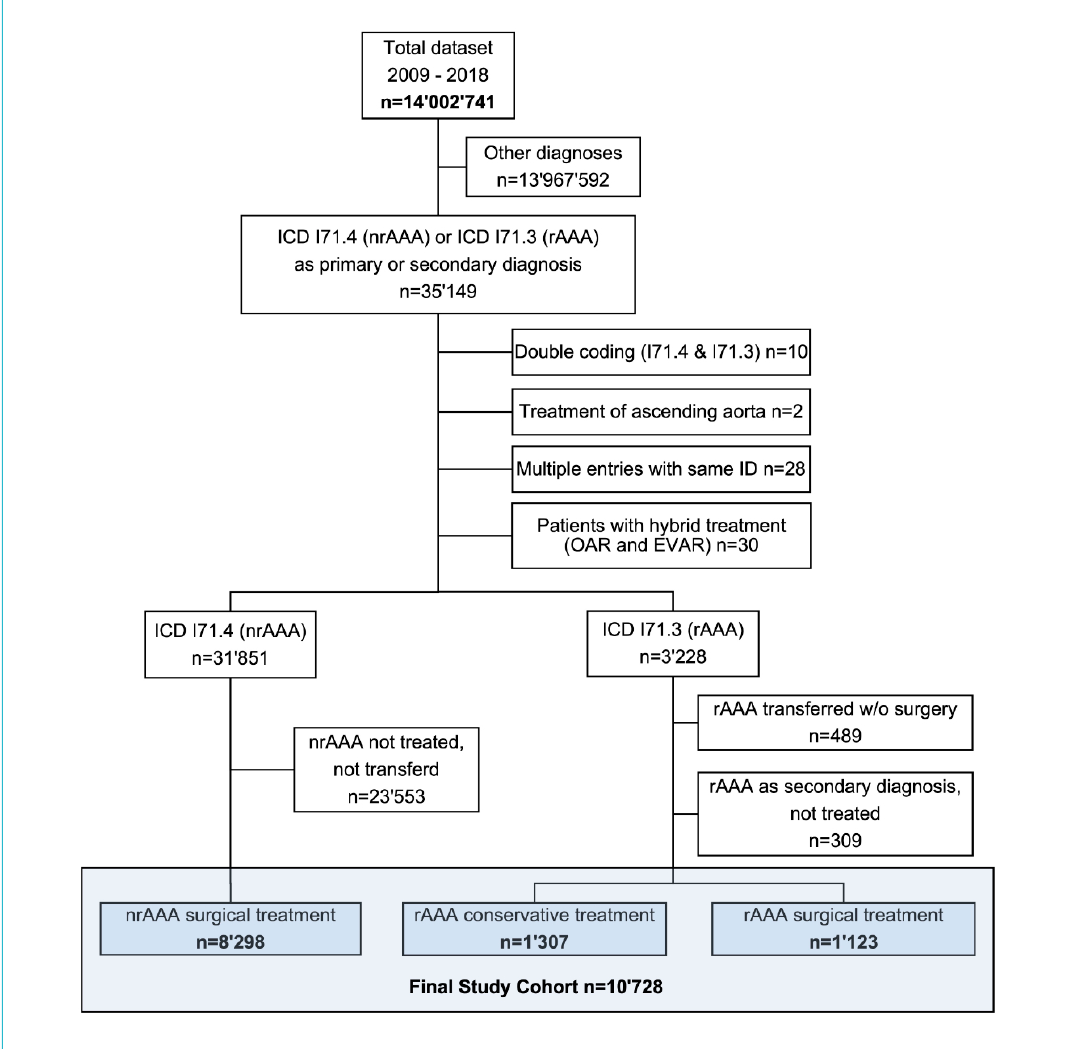
Figure 1: Patient flow. The total dataset contained all hospitalisations in the Swiss population in the years from 2009 to 2018. ICD: Internation- al Classification of Diseases (version 10); rAAA: ruptured abdominal aortic aneurysm; nrAAA: non-ruptured abdominal aortic aneurysm.